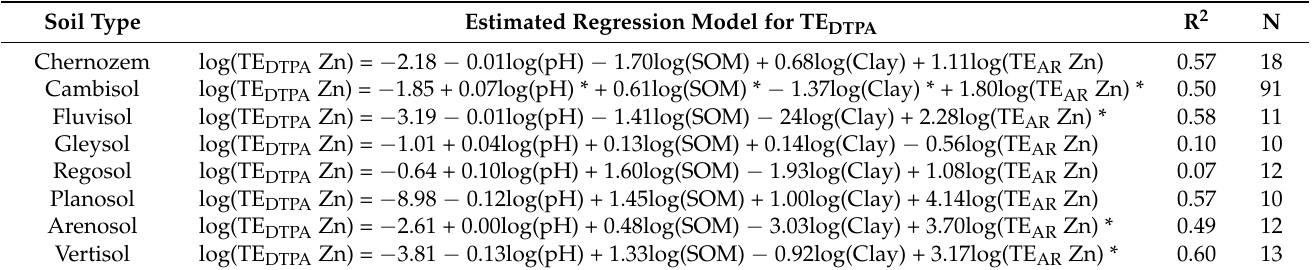
Table 13. Prediction model 10.